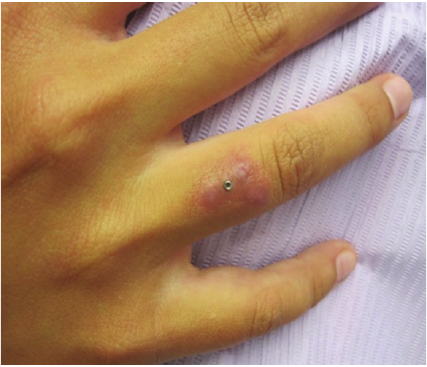
Figure 1: M. fortuitum . Clinical picture of dermal piercing site at the time of infection.